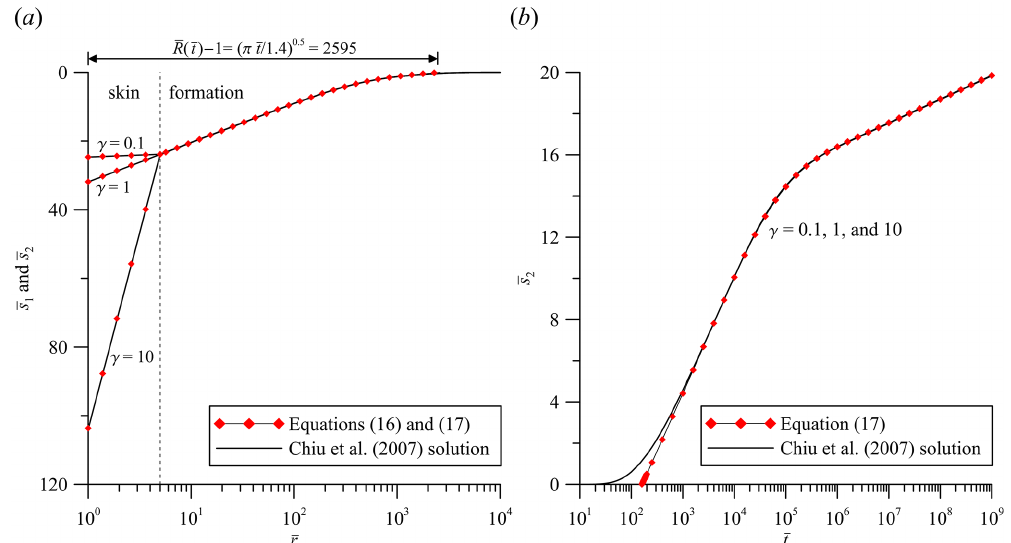
Figure 2. Predicted drawdowns by the Chiu et al. (2007) solution and the approximate solution, Eqs. (16) and (17), with γ = 0.1, 1, and 10 for (a) spatial distributions at t = 3 × 10 6 and (b) temporal distributions at r = 20 with z = 0.5, r s = 5, z 1 = 0.4, z 2 = 0.6, and α 1 = α 2 = 10 − 7 .